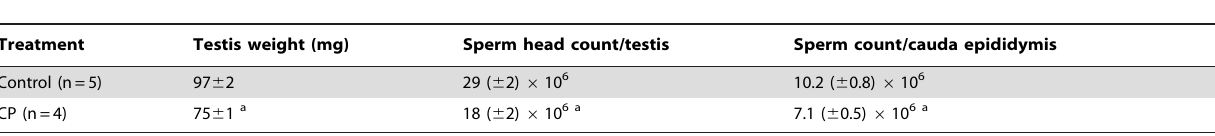
Table 4. Reduction of testis weights and sperm counts in 8-week-old 129S1/SvImJ mice exposed to cyclophosphamide (CP) in utero .